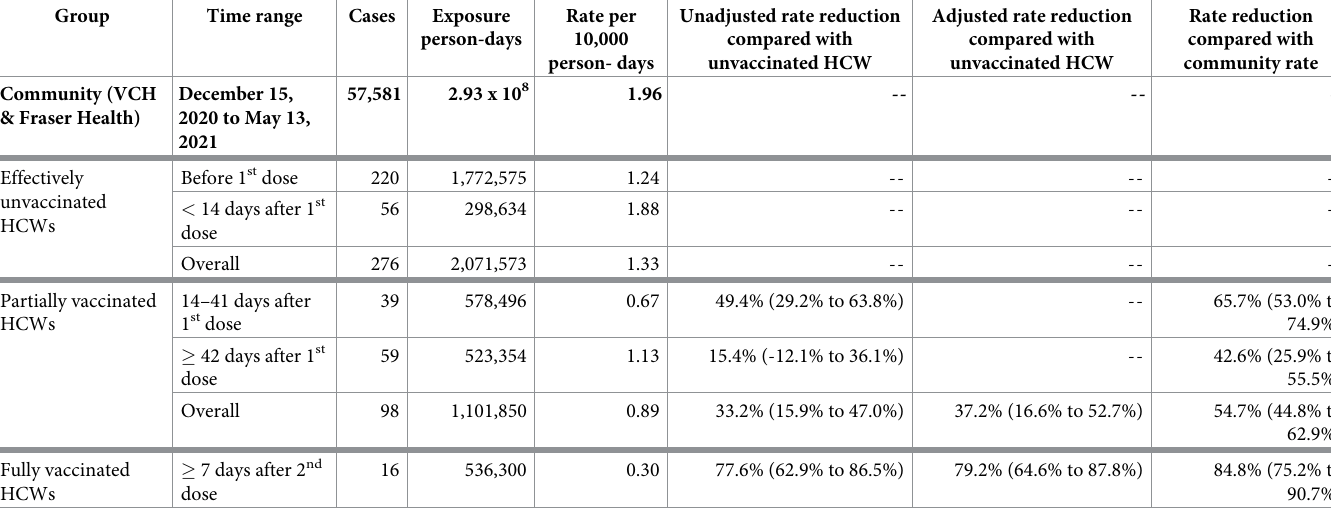
Table 3. COVID-19 positive tests by vaccination status over time in VCH HCWs and community (aged 20–69) from December 15, 2020 to May 13, 2021. The adjusted rate is calculated using Cox regression, adjusting for age and calendar time.